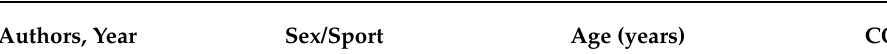
Table 1. Correlations between CODS tests and speed, jump, and strength